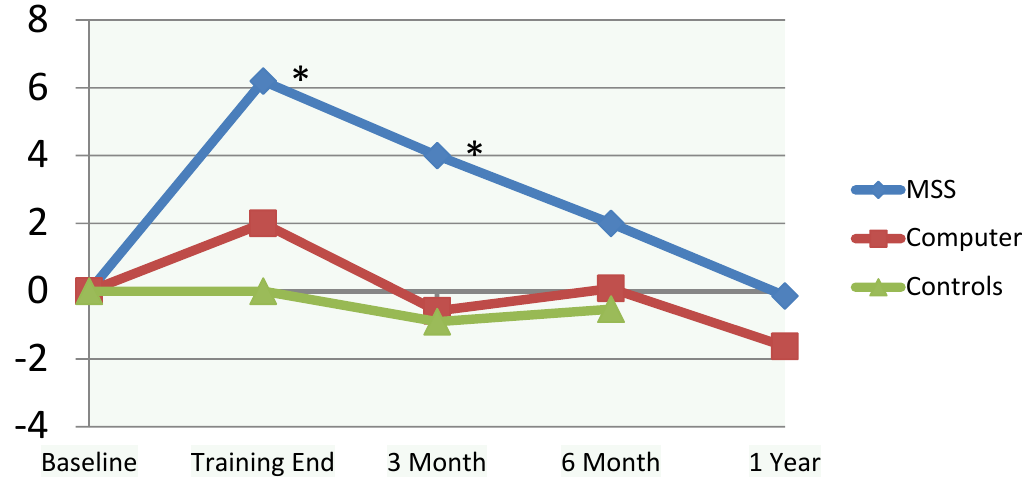
Figure 2. Change in Self Efficacy Over Time. * p < 0.05 within-subject change.